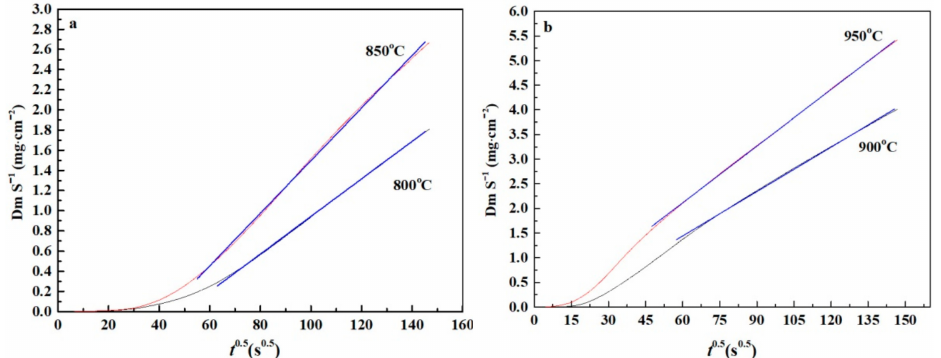
Figure 9. Mass gain vs. t 0.5 graph of the Al coated samples, after isothermal oxidation at ( a ) 800, 850 ◦ C and ( b ) 900, 950 ◦ C.